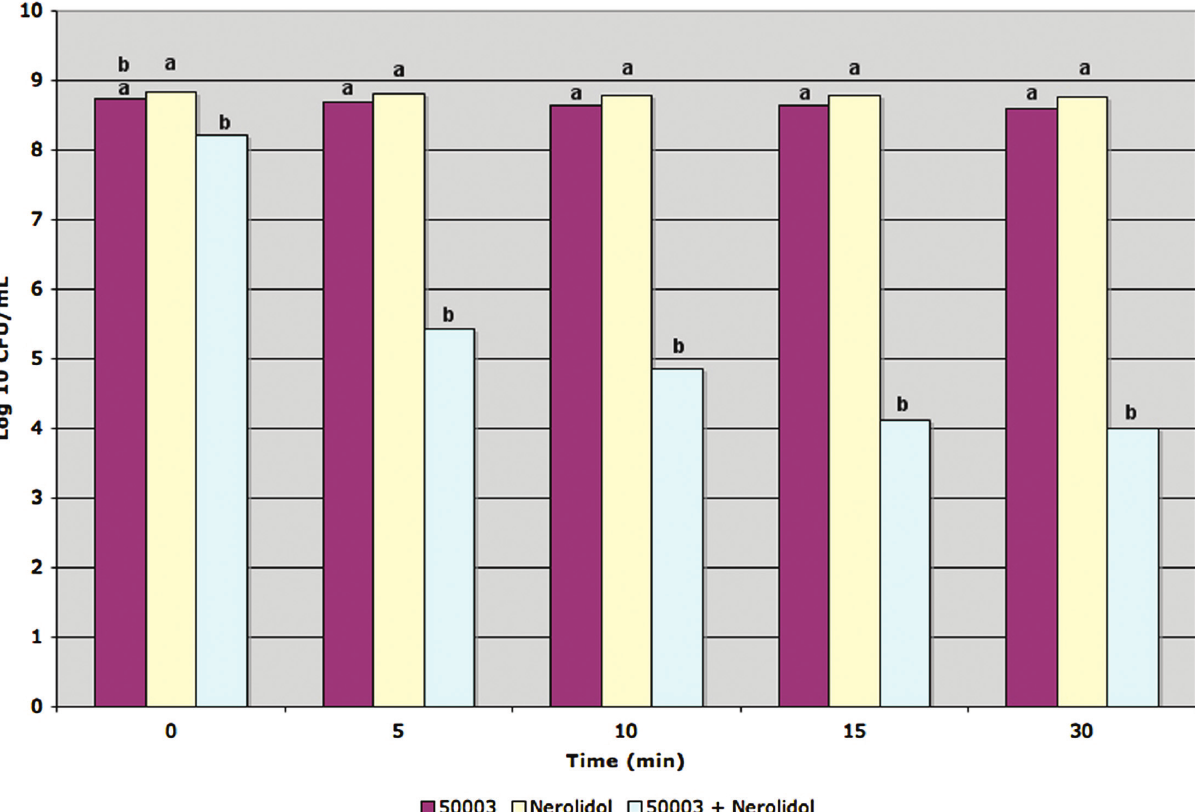
Figure 1. Enhancement of E. coli ATCC 25922 inactivation with PMX polymer 50003. Time course kinetics with 50003 (31.25 µg/mL) and enhancement with nerolidol (200 µM) sampled at 0, 5, 10, 15, and 30 min. Values for each time point having the same letter are not signi fi cantly different at p > 0.05.